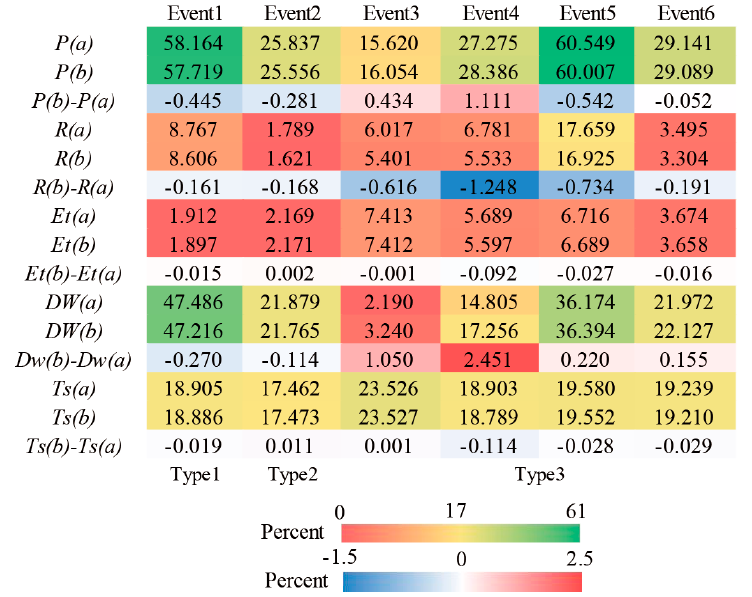
Figure 9. Heat map of grid average values of the crucial elements in the water cycle: ( a ) WRF-only; ( b ) the fully coupled WRF/WRF-Hydro; P , R , Et and Dw are the statistics for the 24 h cumulative values (mm), and Ts represents the hourly grid averaged values (°C).